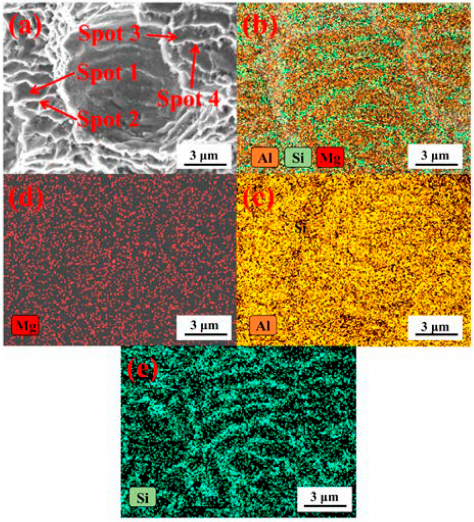
Figure 12. EDS analysis of fracture surface: ( a ) The fracture morphology, ( b ) Overall distribution diagram of fracture elements, ( c – e ) The elemental distribution diagram of Al–Mg–Si on the fracture surface.